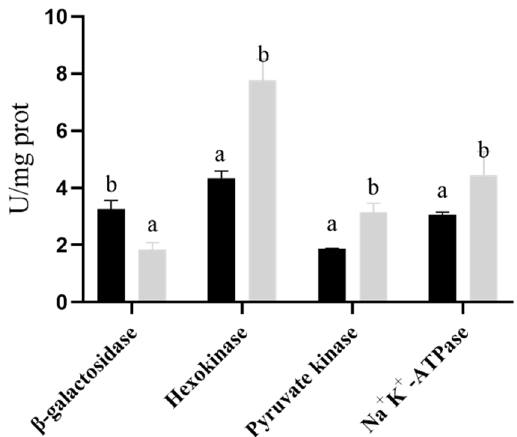
Figure 7. Bifidobacterium longum CCFM 1029 intracellular and extracellular enzyme activity test. The black column represents the control group pressure, and the gray column represents the experimental group pressure. Columns with different letters indicate significant differences ( p < 0.05).